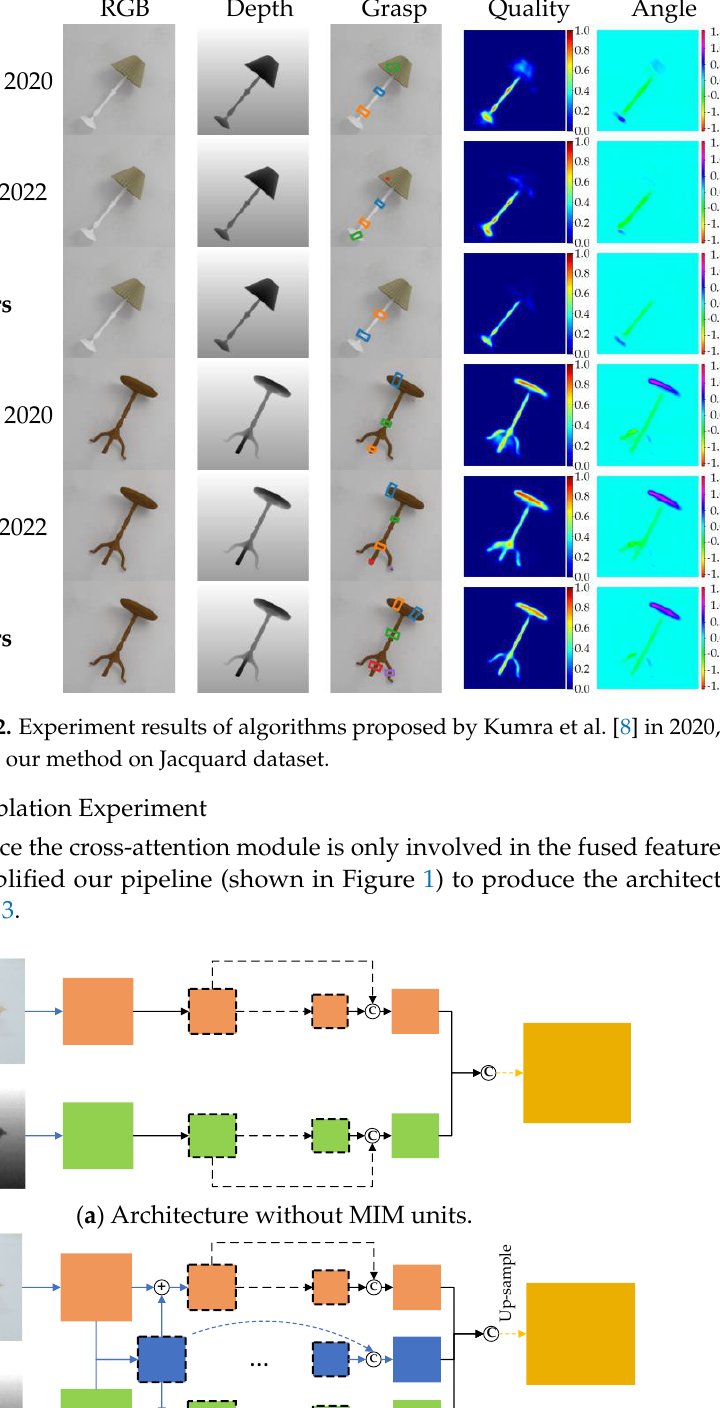
Table 4. Object-wise grasp detection results of ablation experiment on Cornell and Jacquard da-